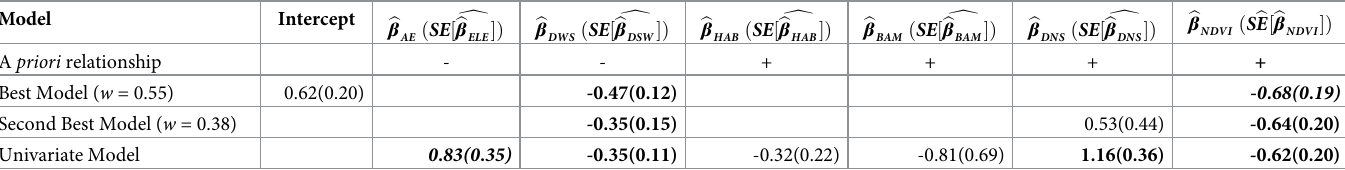
Table 2. β estimates and standard errors [in parentheses] from the logit link function based on the best and the univariate, single-species, single-season occupancy models for red panda detection probability (p) in mid-hills and high Himalayas in 2016. Model